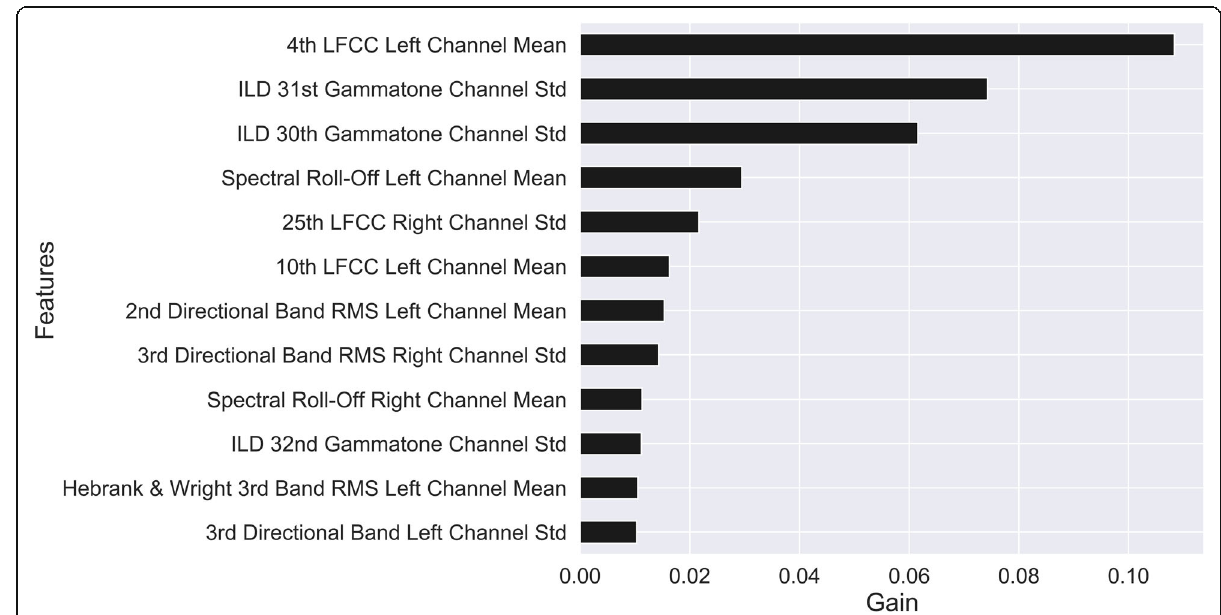
Fig. 16 Feature importance for the twelve most prominent features as identified by XGBoost classification algorithm ( “ Std ” denotes standard